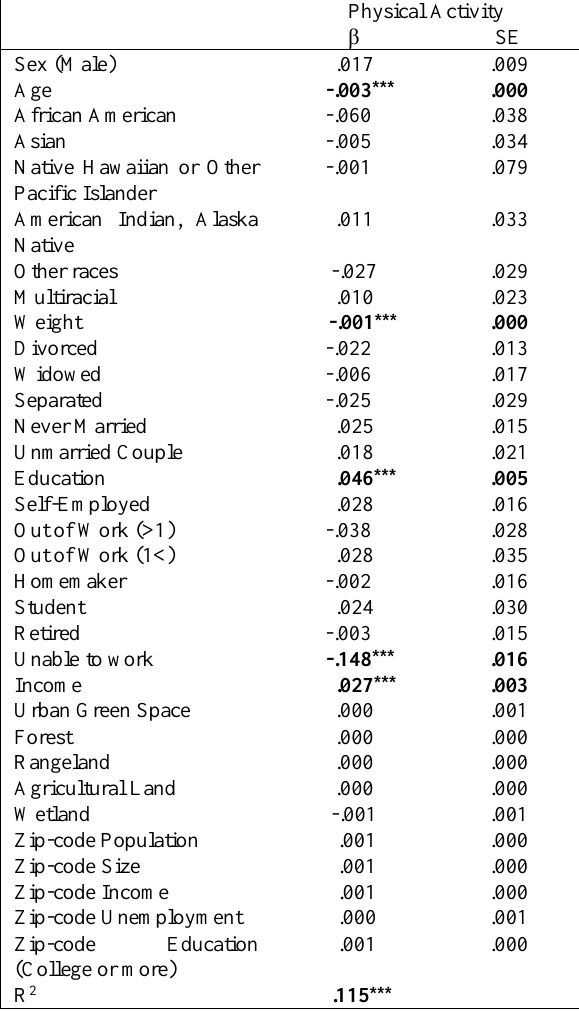
Table 2. The associations between types of green space White, Married, and Employed are the reference